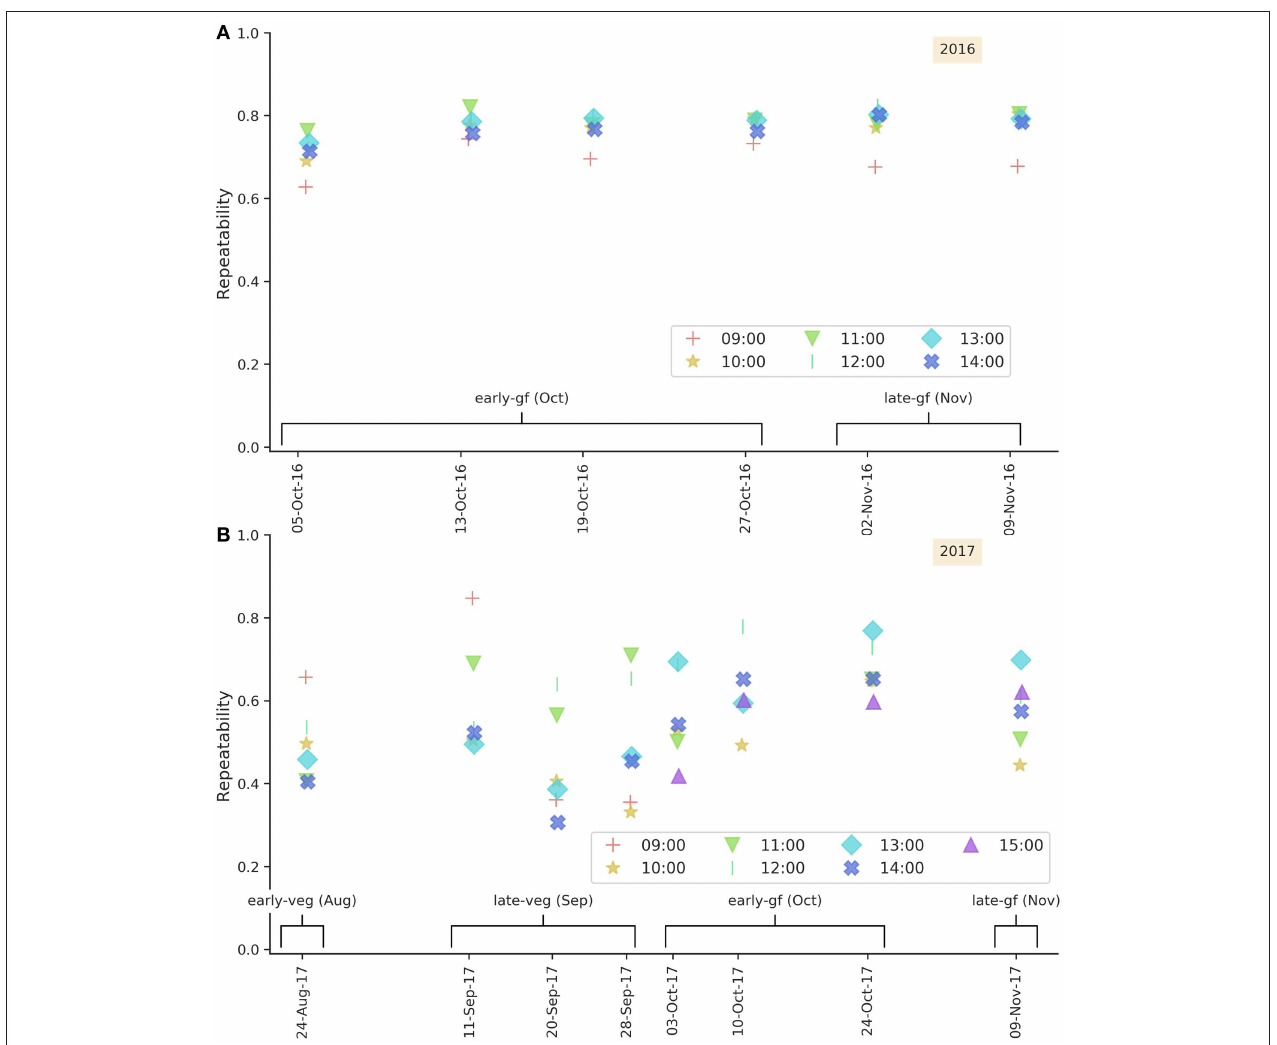
FIGURE 6 | Repeatability estimates for airborne canopy temperature shown as scatter plots for each date in 2016 (A) and 2017 (B) with hour-of-day denoted as per legend. Growth stage is denoted as follows: early-veg, early vegetative; late-veg, late vegetative; early-gf, early grain-filling; late-gf, late